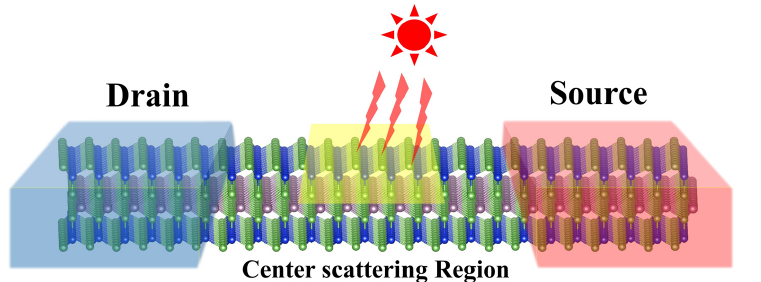
Figure 7. Schematic structure of monolayer MoSi 2 Z 4 -based 2D optoelectronic device. The yellow zone in the center scattering region stands for the lighting area. The left blue region and right red region represent the drain and source,